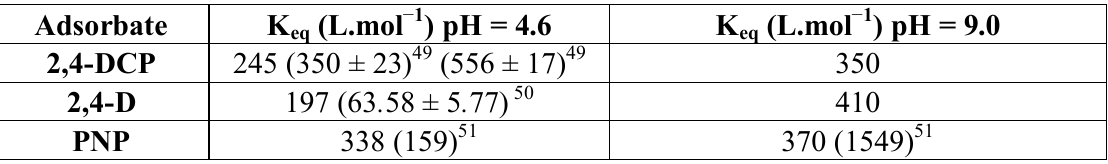
Table 3. Experimental and literature 1:1 binding constants for  -CD/guest complexes in aqueous solution at 295 K and various pH conditions according to spectroscopic and calorimetric titrations.